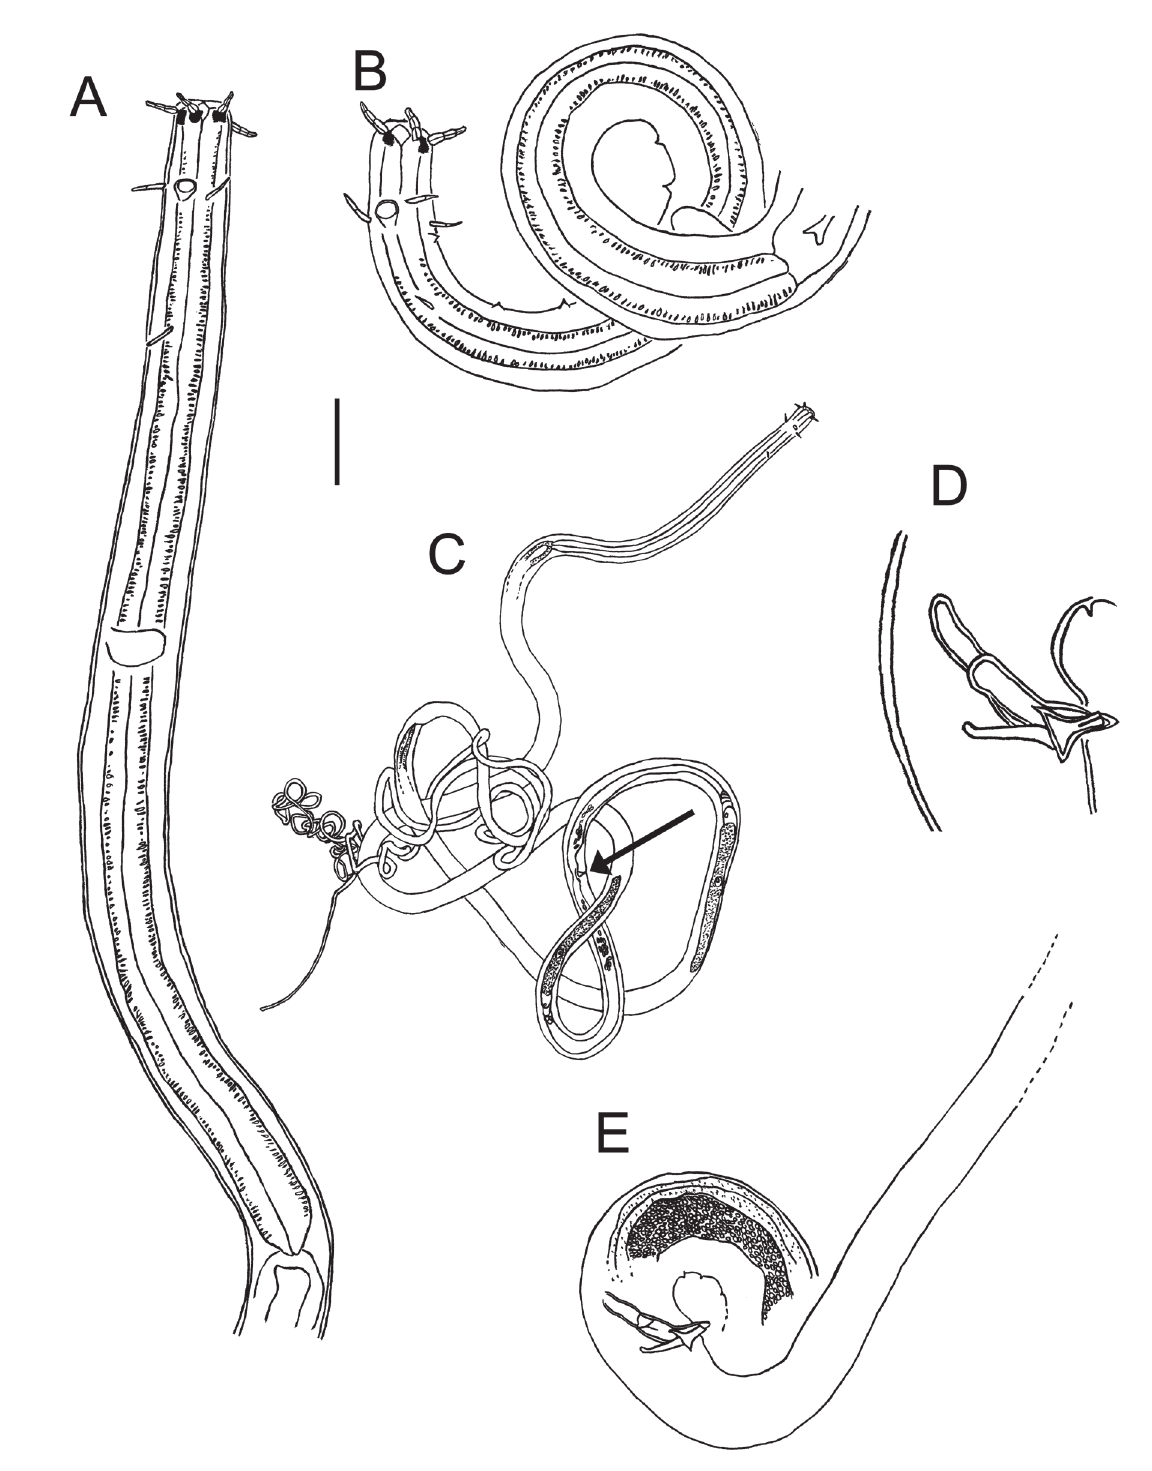
Fig. 1. Trefusia piperata sp. nov. A . Anterior body region of female. B . Anterior body region of male. C . entire female. D . Right spicule and gubernaculum. E . Posterior body region of male. Arrow shows position of vulva. Scale bar: A-B, E = 20 µm; C = 75 µm; D = 8